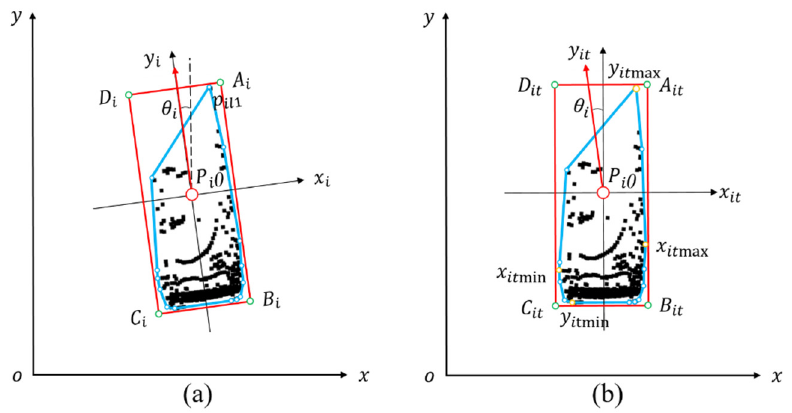
Figure 8. Illustration of the RPCA algorithm: ( a ) the original coordinate system of the RPCA; ( b ) the coordinate system after forwarding rotation. The red arrow represents the direction of obstacles extracted by the PCA. The essence of the RPCA algorithm is its use of the direction obtained by the PCA to find the corner points of the two-dimensional bounding box by twice rotating the coordinate points forward and backward.